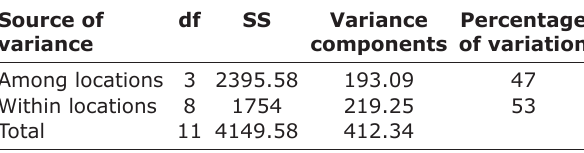
the variance components and the percentage of variation, are shown. SS=Sum of squares, AMOVA=Analysis of molecular variance, M. cephalus=Mugil cephalus , AFLP=Amplified fragment length polymorphism